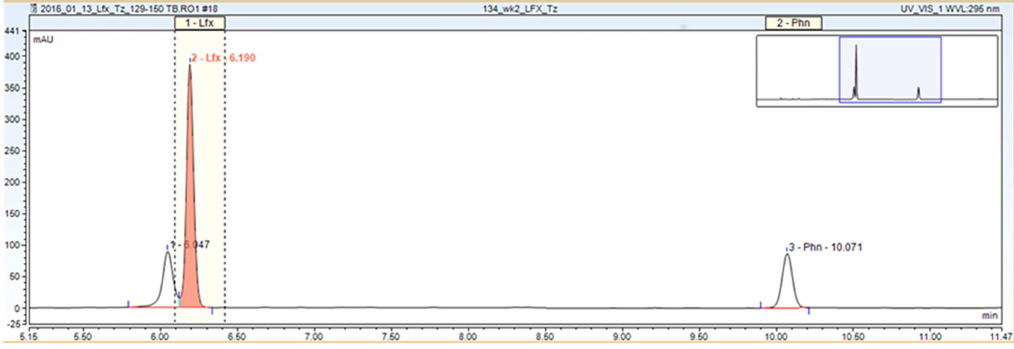
Fig 1. Representative HPLC-UV chromatogram for levofloxacin with phenacetin (Internal standard). Representative Chromatogram for